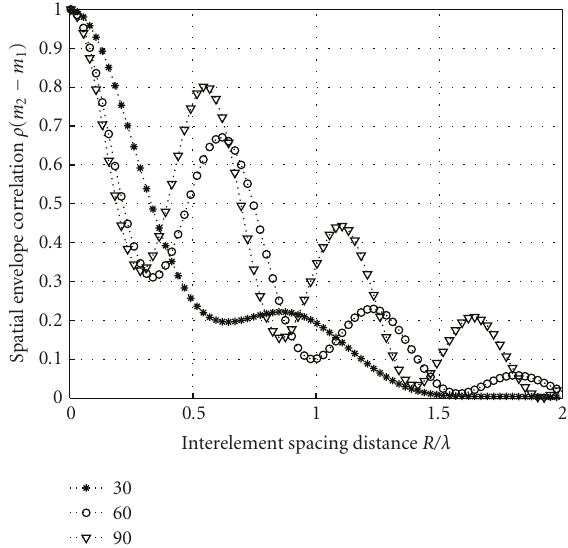
Figure 8: Spatial correlation for the 3-component VMF mixture. In this case, the priors are set such that the 2nd cluster in the mixture has a higher value, that is, ρ 2 = 0 . 6, and the remaining two spatial clusters have ρ 1 = 0 . 2 and ρ 3 = 0 . 2,